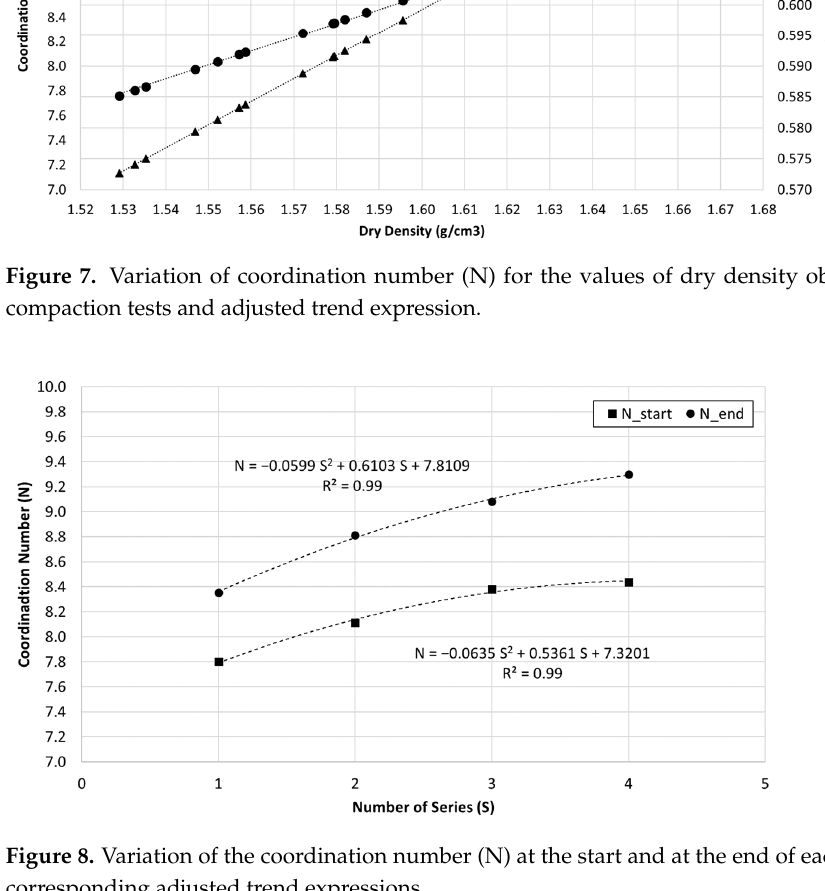
Figure 7. Variation of coordination number (N) for the values of dry density obtained after the com- paction tests and adjusted trend expression.